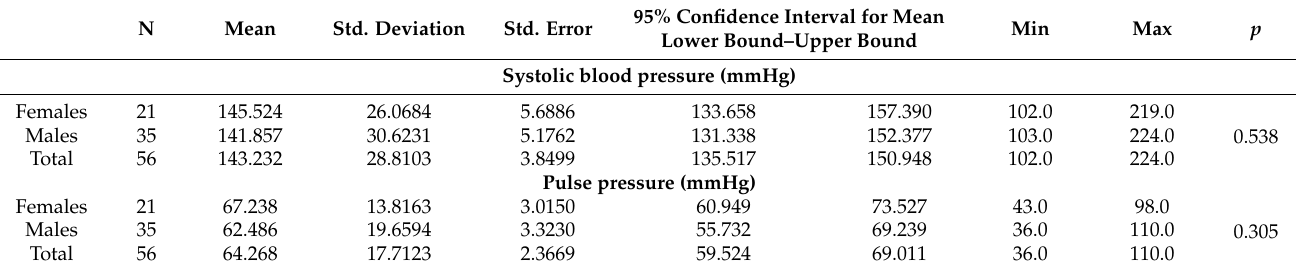
Table 1. Gender distribution of systolic blood pressure and pulse